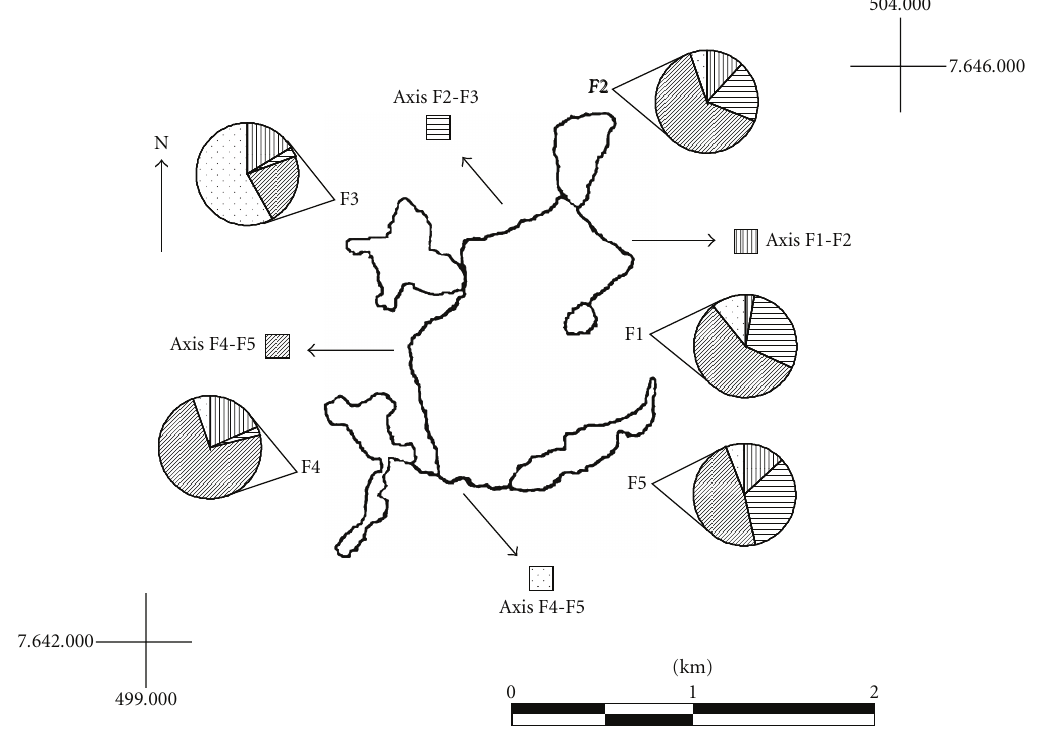
Figure 1: Location of the study system with forest fragments and ecological corridors in Minas Gerais state, Brazil. F1 to F5 (fragments) and Axis F1-F2 to F4-F5 (ecological corridors). Distances between fragments varied from 0.8 to 2km. The circles represent the contribution to total genetic di ff erentiation of each fragment with the corridors, using